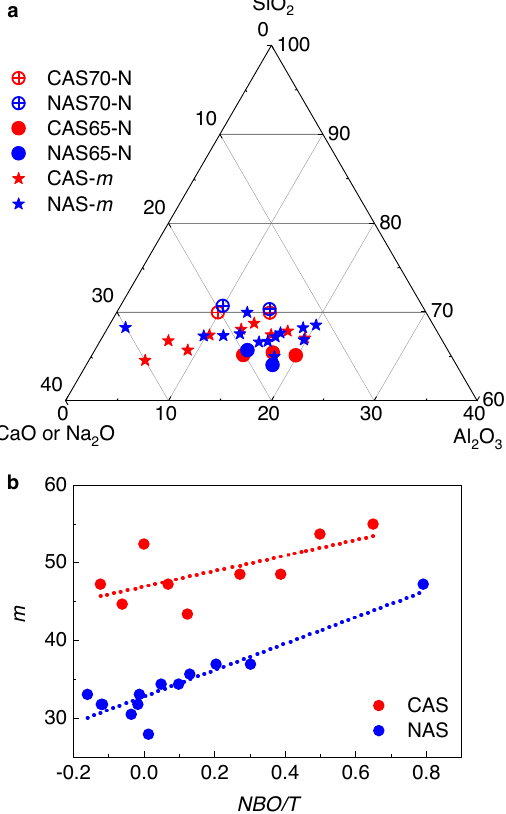
tothe m -measuredones.TheFSDPsof70mol%SiO 2 glassesareshiftedupby0.5for clarity. The average MRD-NBO/T correlation of two NAS-lines (blue solid and dotted lines) ( e ) is used to calculate the MRD values of m -measured NAS glasses. The changing trends of m ( b ) are inversely correlated with the changing trends of MRD ( e ).The higher m -valuesofCASglasses( b ) show lower MRD values( e );thelarger m - slope of NAS ( b ) is also supported by the larger negative MRD -slope for NAS ( e ).